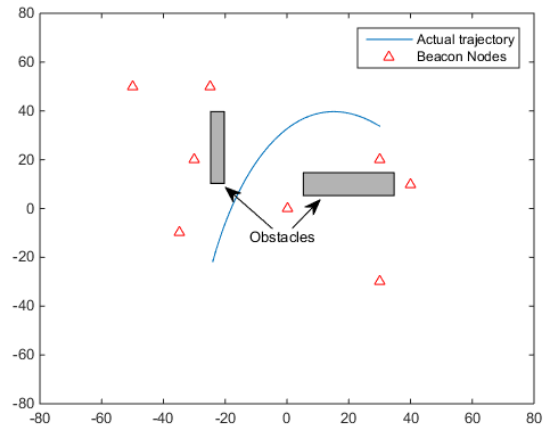
Figure 4. The deployment of beacon nodes and obstacles. Table 2. The default parameter values.